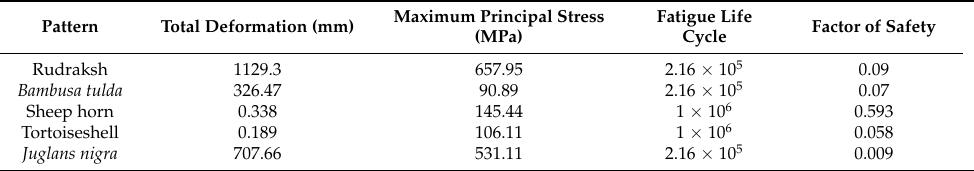
Table 3. Simulation study comparison for sheep horn material.